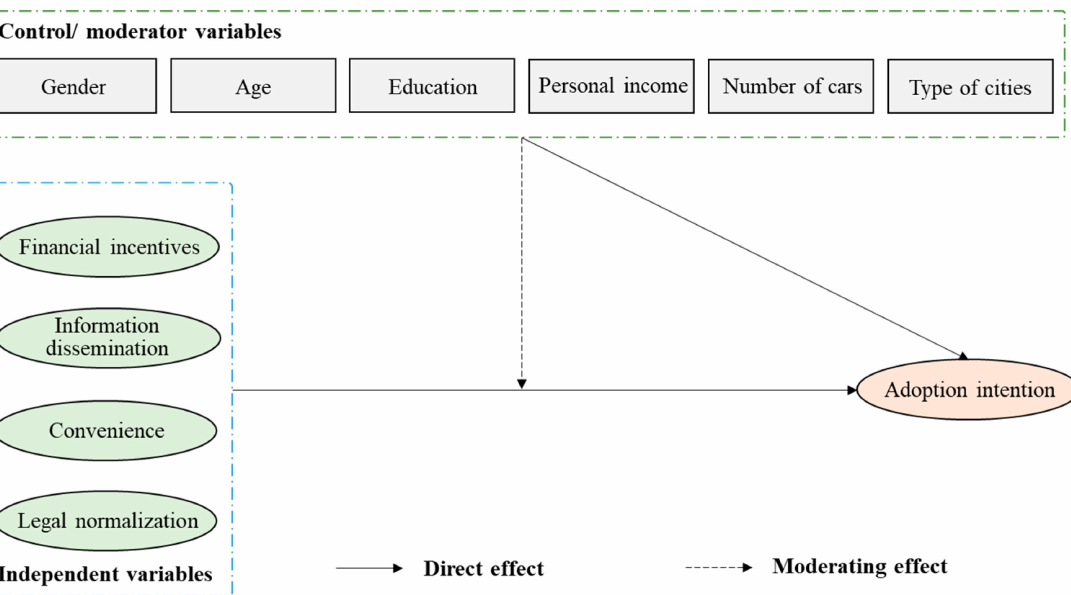
Figure 2. Research framework of relationships among policy measures, demographic factors, and AV adoption